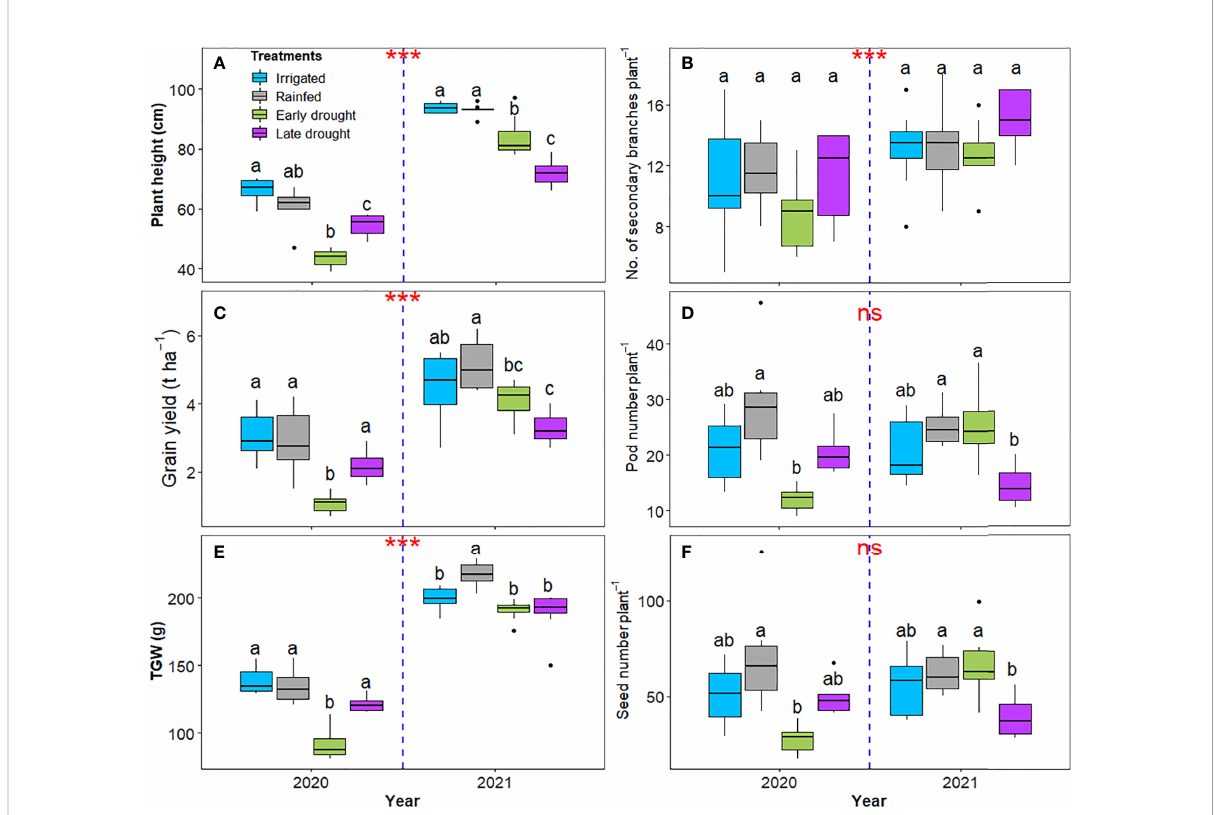
FIGURE 5 Boxplot of yield structure of soybean under four water treatments in 2020 and 2021. Plant height (A) , number of secondary branches per plant (B) , grain yield (C) , pod number per plant (D) , TGW (E) , and seed number per plant (F) . The different letters above the boxplots represent Tukey ’ s HSD test (p < 0.05) among the different treatments (n = 6 in 2020 and n = 8 in 2021). Asterisks above the blue dashed indicate signi fi cant differences between the two years based on ANOVA result at P < 0.05; *** P < 0.001, ns; not signi fi